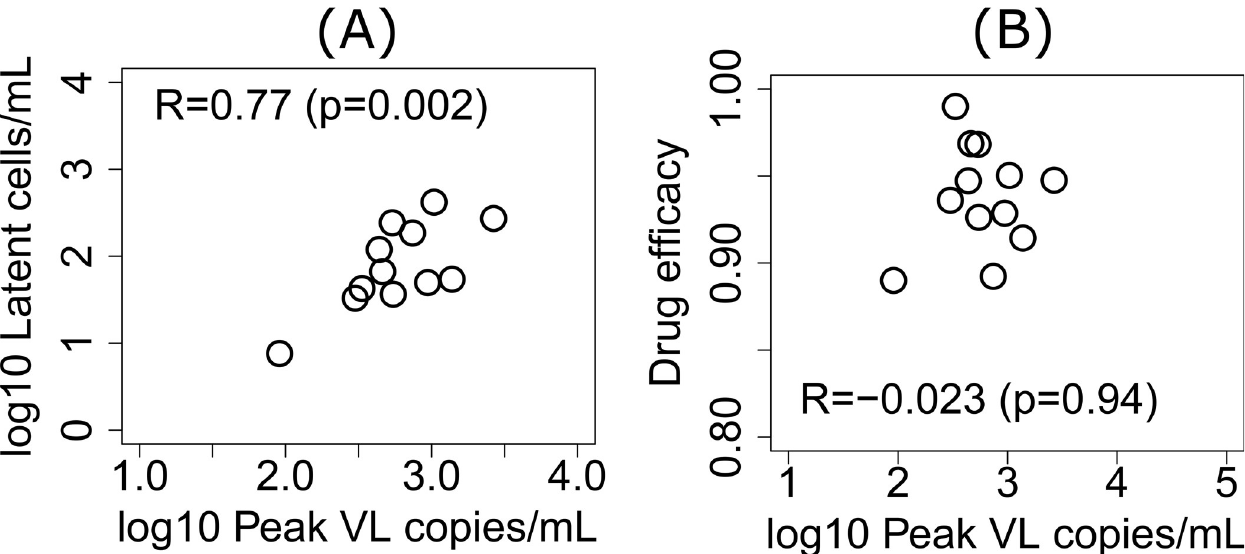
Fig 3. The CTL-VC model predicted a strong positive correlation (A) between the peak VL after CD8 depletion and the predicted latent reservoir size before depletion, when drug efficacy was fixed at 0.9, and a weaker negative correlation (B) between the post depletion peak VL and the estimated drug efficacy when the fraction of latent infection α L was fixed at different values for each